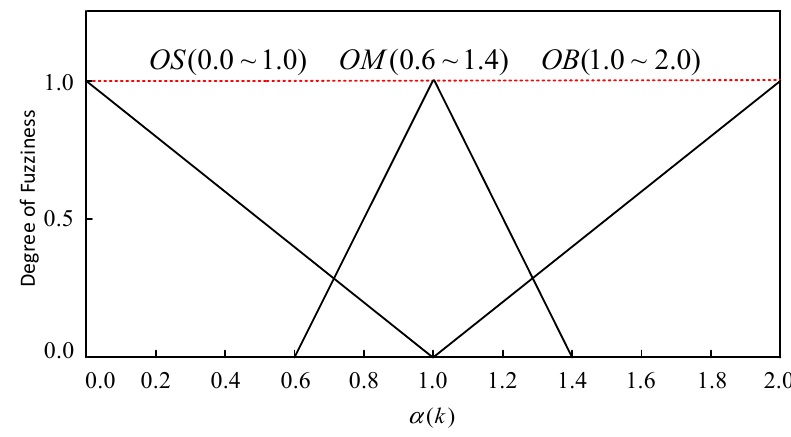
Figure 5. Output membership function.